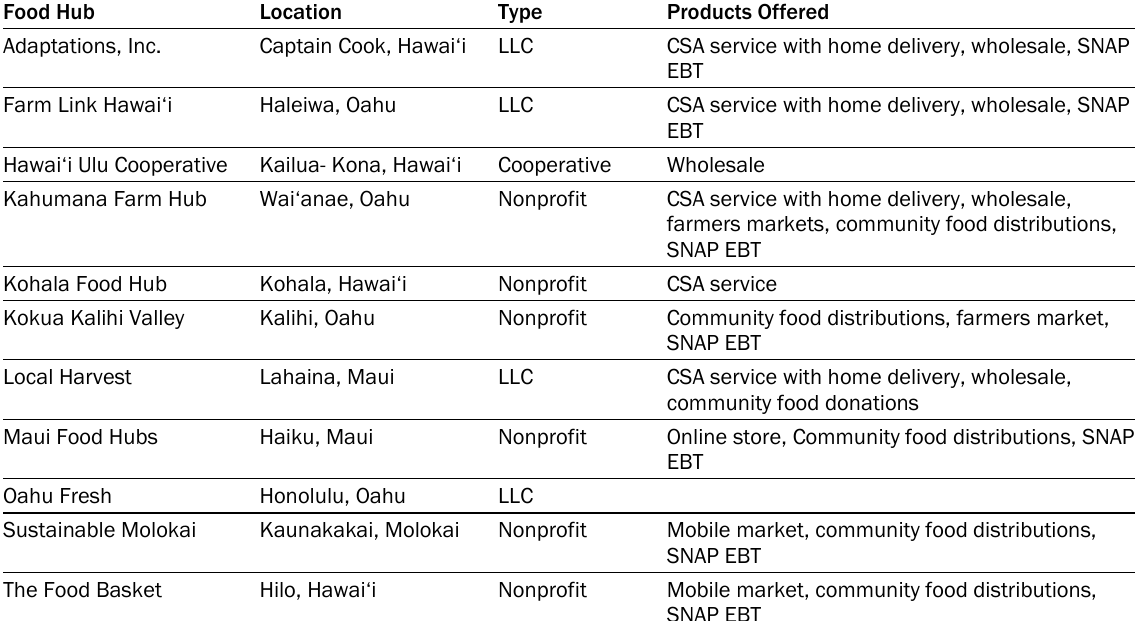
Table 1. Food Hubs in Hawai‘i that Participated in This Study These represented the vast majority of the total volume and sales of all food hubs in the state. Food Hub Location Adaptations, Inc.